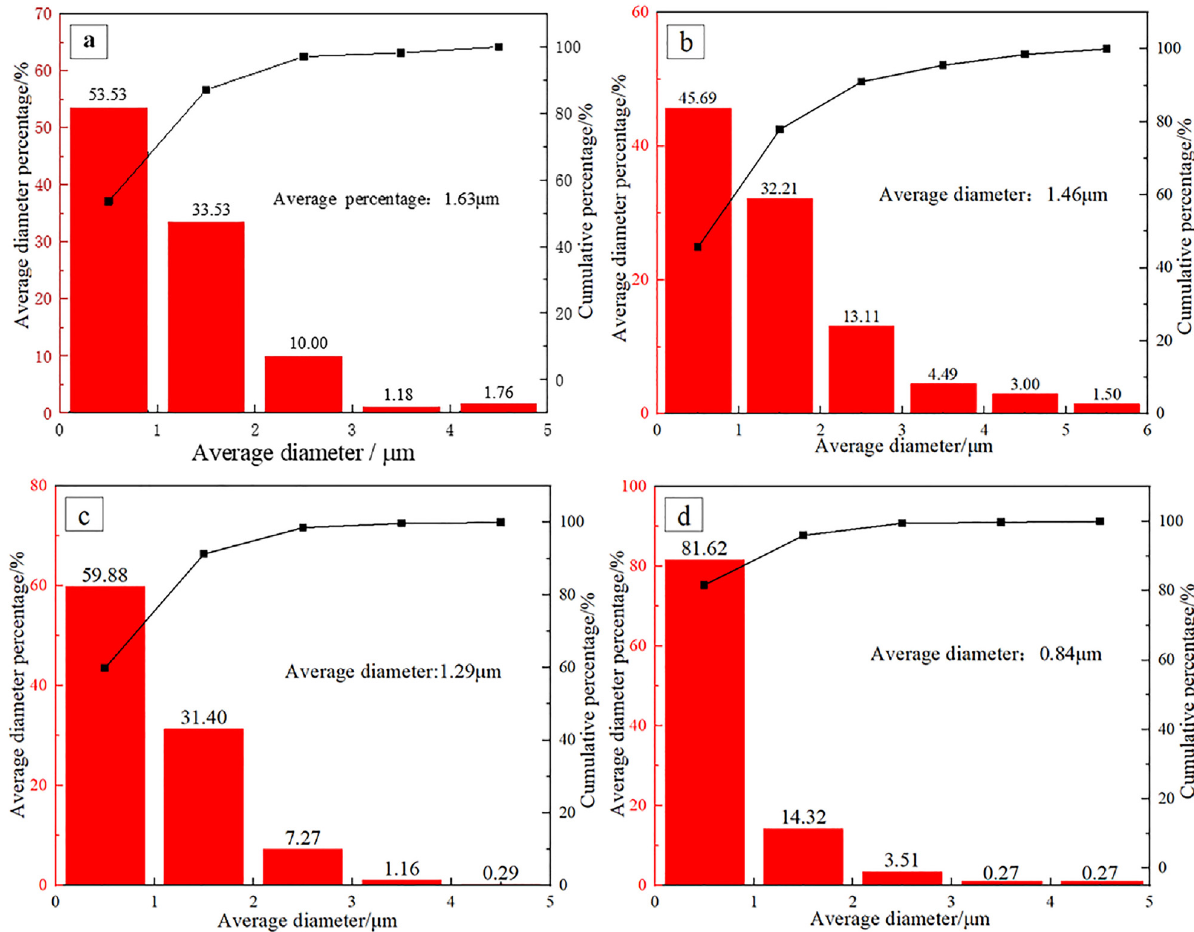
Figure 11: Distribution of the metal particles in the slags obtained with di ff erent R ( C/A ) ( a: 0, b: 0.2, c: 0.6, and d: 1.0 )